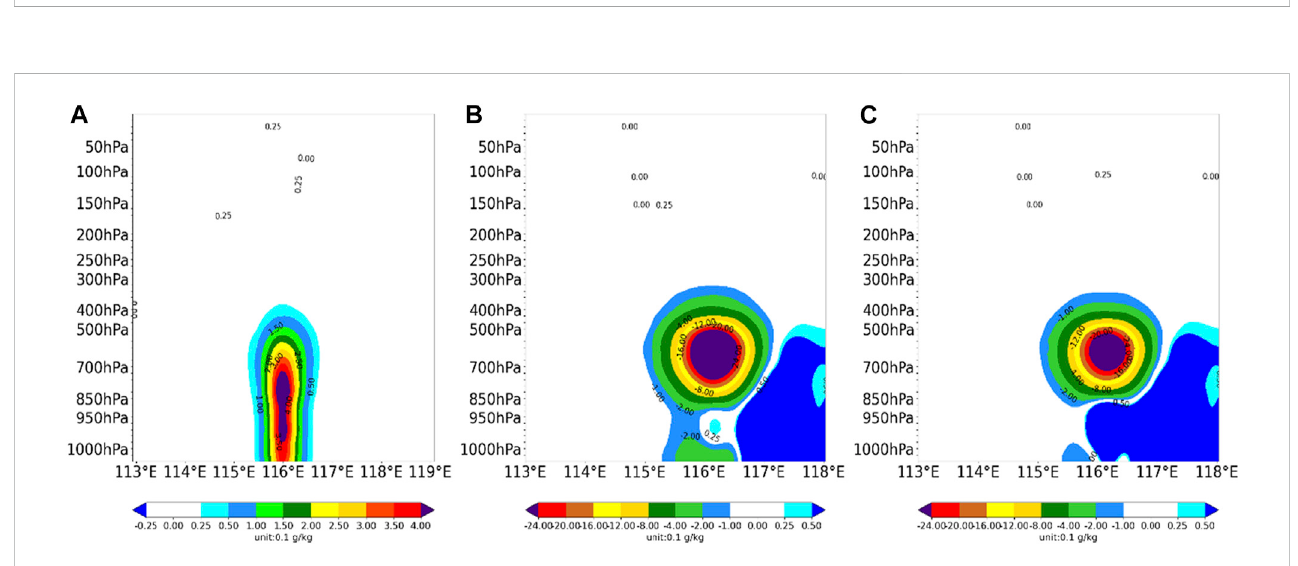
FIGURE 9 The cross sections of the speci fi c humidity increments (shaded; unit: g/kg) along 40 ° N from (A) MWR_DA, (B) AGRI_DA, and (C) A +